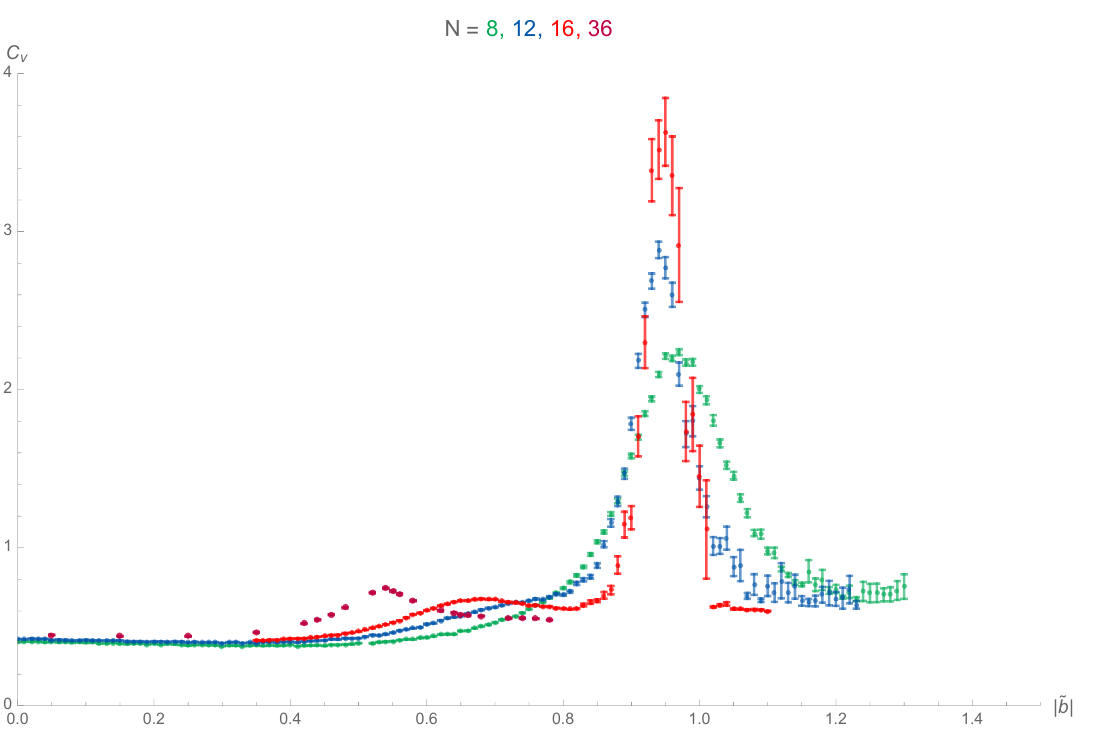
Figure 1 . The speci(cid:12)c heat for small N and ~ c = 0 : 20. In the N = 8 plot only the main peak corresponding to the non-uniformly to uniformly ordered phase boundary is visible. The plots for N = 12 and N = 16 show the emergence of the secondary peak corresponding to the disordered to non-uniformly ordered phase boundary. For N = 36 only the latter peak is visible. the triangles we use to locate the triple point. It should not be taken as the true coexistence curve. Rather the coexistence curve is a continuation of the line l coexistence curves in the vicinity of the triple point fall on the one, surprisingly straight, line through the